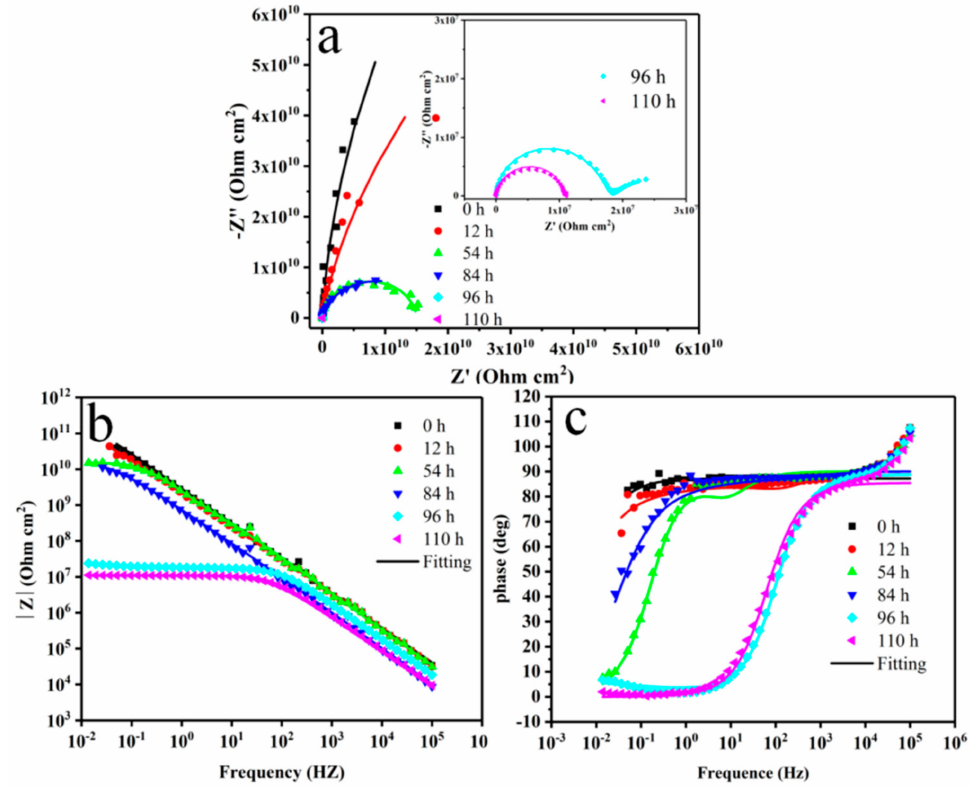
Figure 7. Impedance plots ( a – c ) of neat epoxy resin coatings immersed in a 3.5 wt.% NaCl